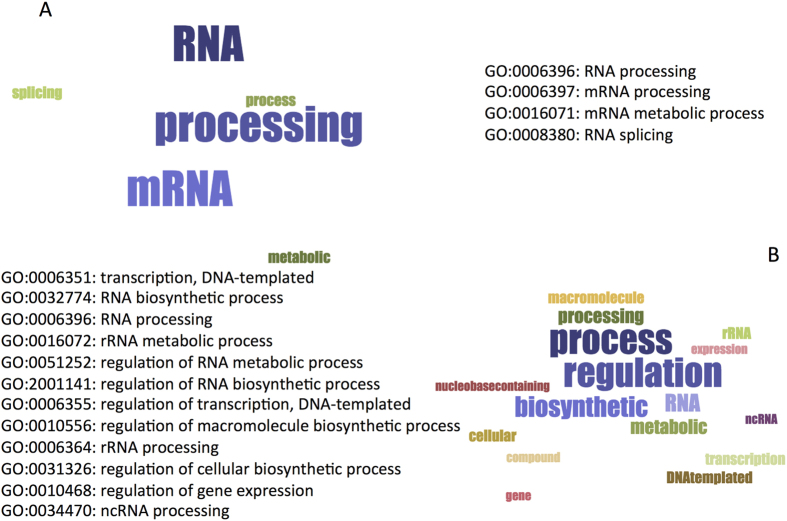
Nucleic acid binding and gene ontology analysis.multiCleverMachine analysis of AmiGO annotations51 indicate that proteins containing poly-R (A) and poly-E homo-repeats (B) reveal the increase in RNA- and DNA-binding abilities. GO labels are shown together with word-cloud visualization (p-values < 0.01 calculated with Bonferroni’s correction on whole human proteome). The analysis is available at the following links http://www.tartaglialab.com/GO_analyser/render_GO_universal/839/3158792f91/(poly-E) and http://www.tartaglialab.com/GO_analyser/render_GO_universal/840/ea98f8b320/(poly-R).